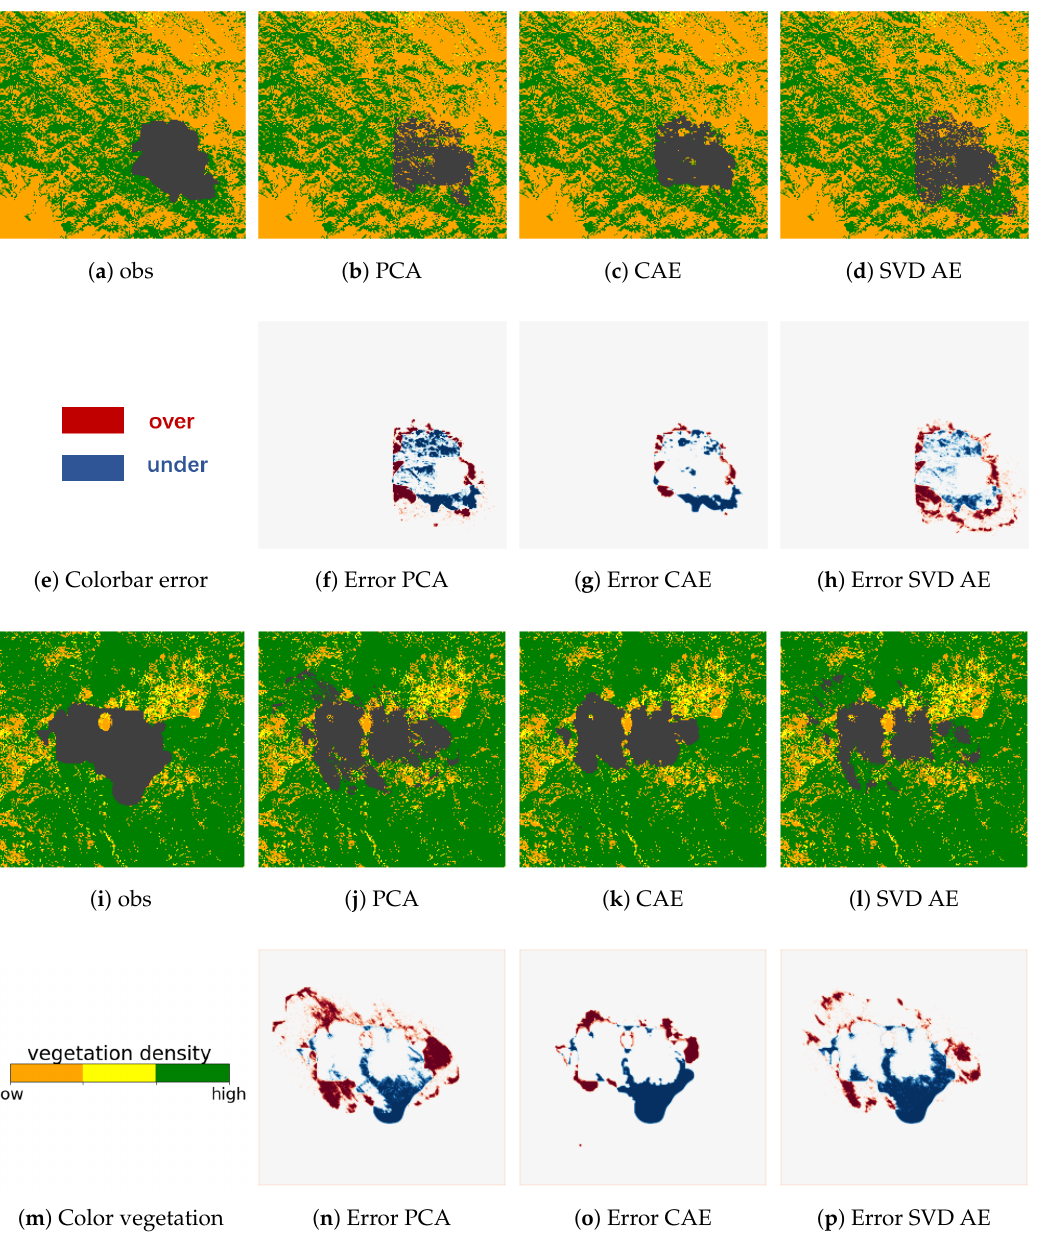
Figure 7. Reconstruction of the satellite observation for the Chimney ( a – h ) and the Ferguson ( i – p ) fire at day